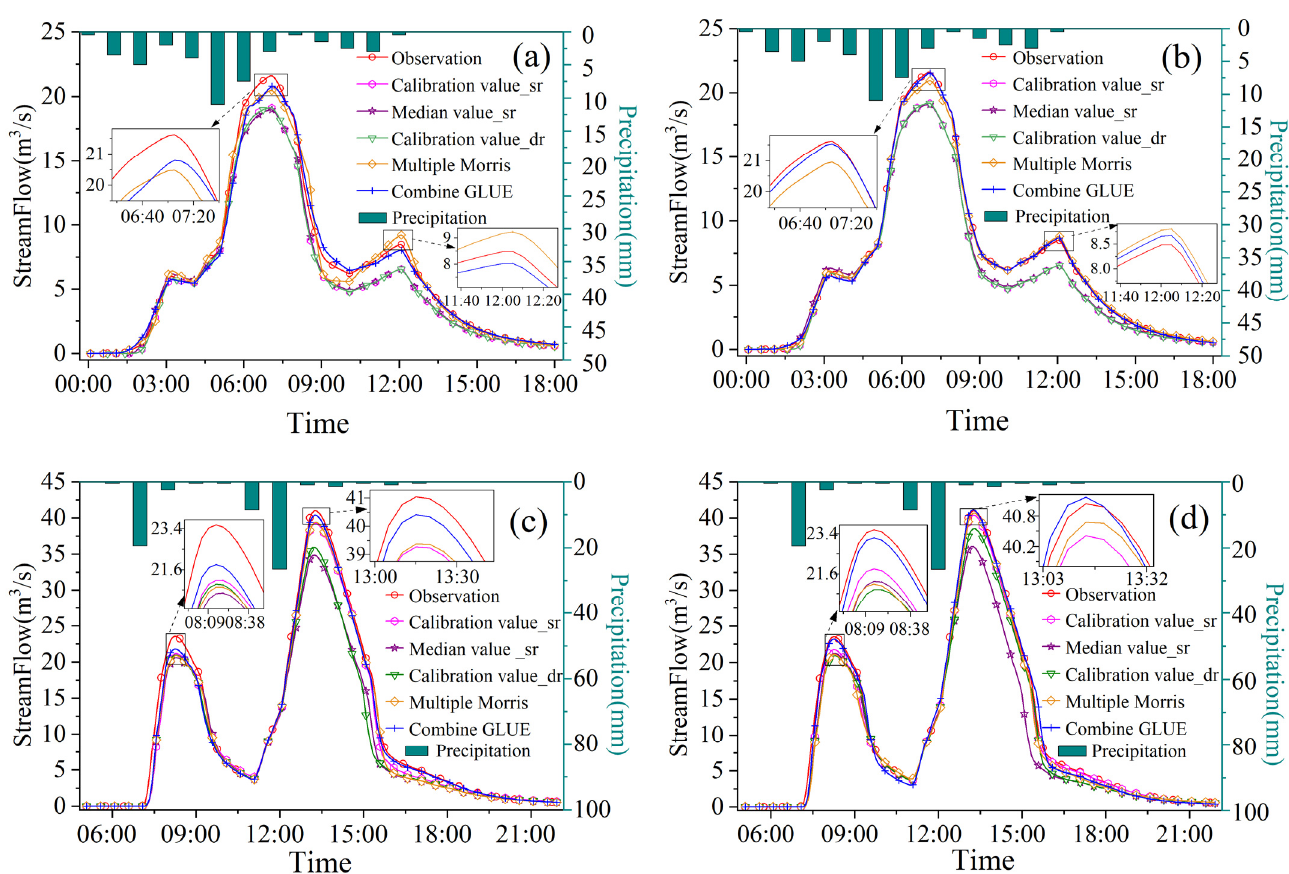
Figure 6. Model flow simulation results during the calibration period: ( a ) Genetic Algorithm with a single-objective for rainfall event 0819; ( b ) Genetic Algorithm with multi-objective for rainfall event 0819; ( c ) Genetic Algorithm with a single-objective for rainfall event 0515; ( d ) Genetic Algorithm with multi-objective for rainfall event